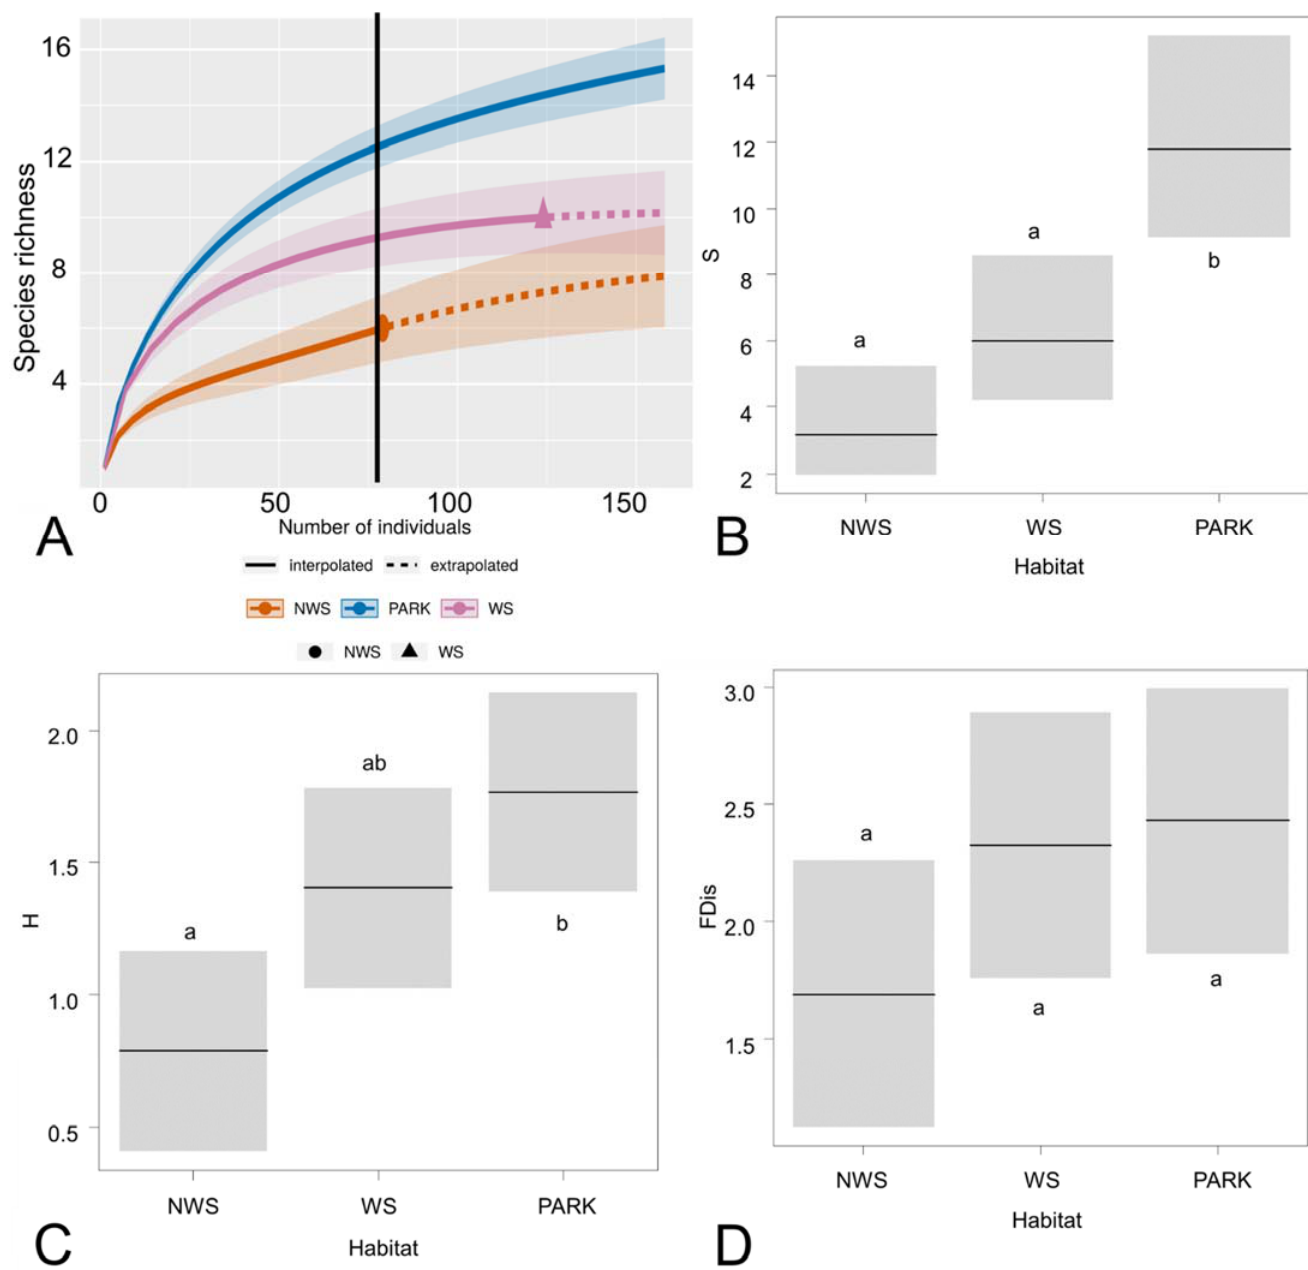
Figure 2. Bird taxonomic and functional diversity in different urban habitats. ( A ) Rarefaction curves estimated by the iNEXT software. The vertical black line in the rarefaction curve indicates the minimum number of individuals that we used to compare species richness between habitat types, and it corresponds to the greatest interpolated species richness of NWS. ( B ) GLM plot of species richness (S) estimated by COMDYN. ( C ) GLM plot of species diversity (H ′ ). ( D ) GLM plot of Functional dispersion index (FDis). NWS = Non-Wooded Streets, WS = Wooded Streets. In ( B – D ), the horizontal black line represents the average value of the response variable for each habitat type and the grey bands are 95% confidence intervals. The different letters (a,b) indicate significant differences between the habitat types ( p < 0.05).